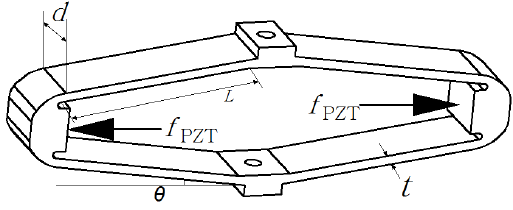
Figure 7. Diamond amplifier.